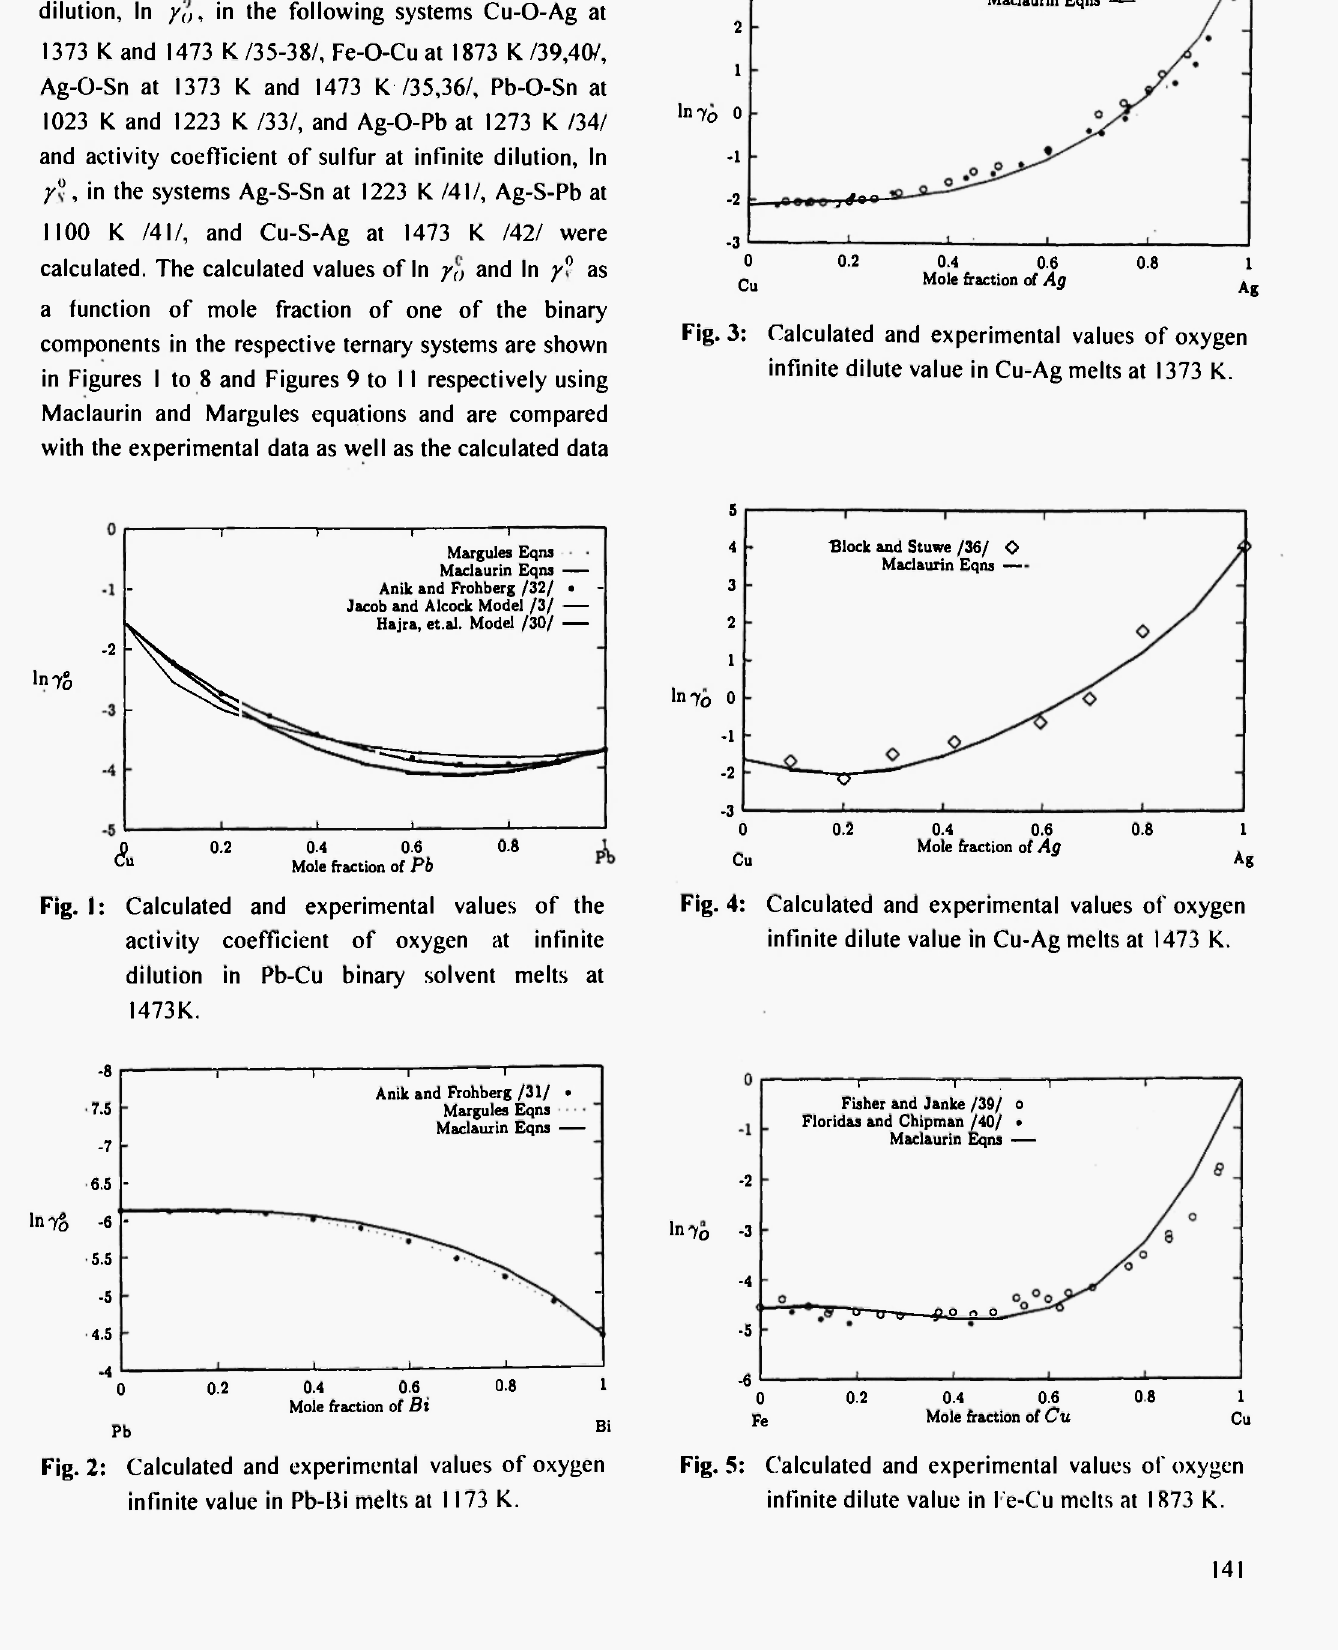
Fig. 2: Calculated and experimental values of oxygen infinite value in Pb-Bi melts at 1173 K.